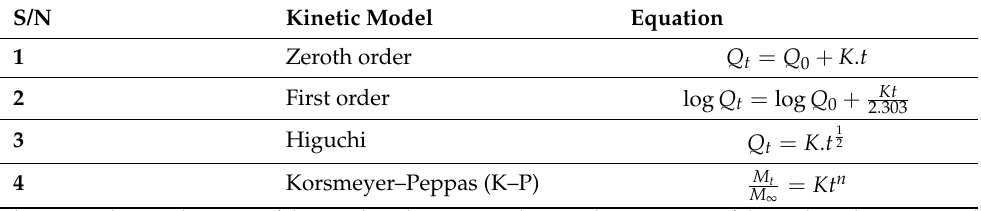
Table 1. Kinetic models and their respective equations.